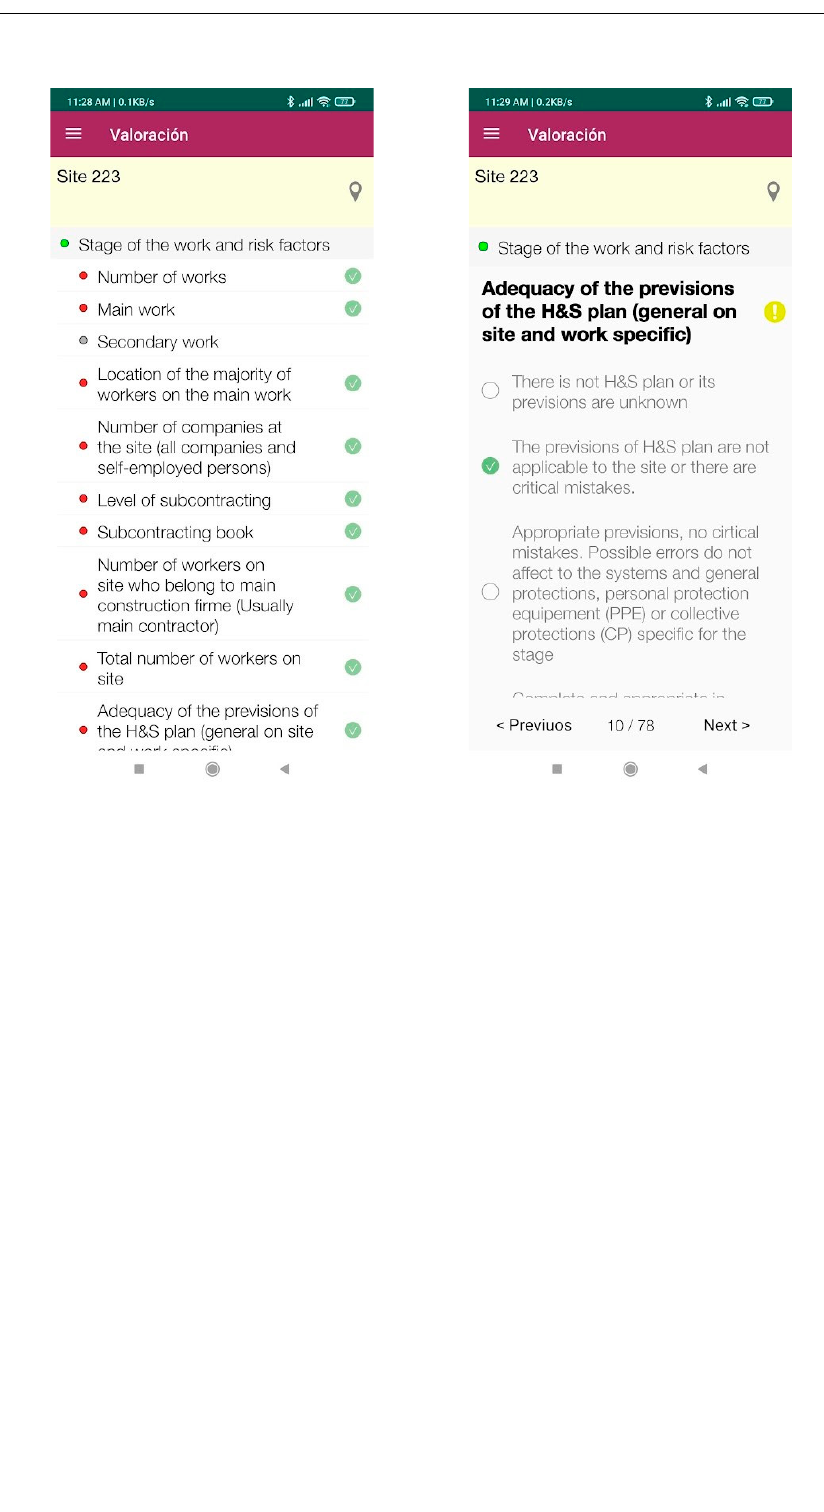
Figure A3. Different screens showing site assessment, general menu, and specific questions with possible answers. Source: App screenshots.